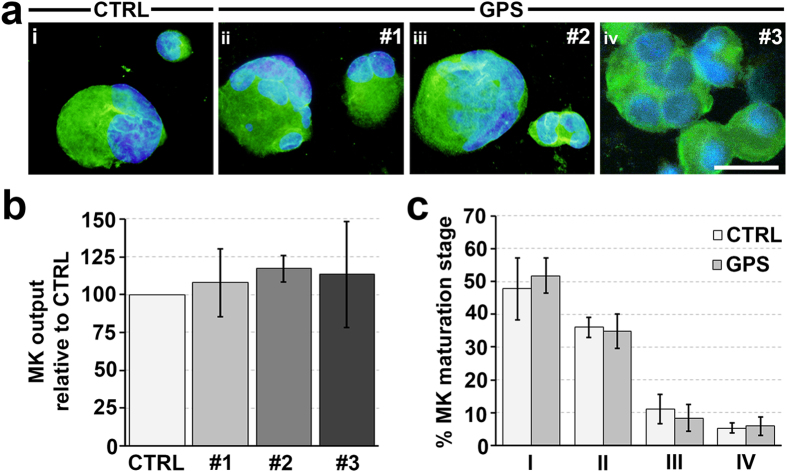
Normal differentiation of human megakaryocytes from patients with GPS.Hematopoietic progenitors from peripheral blood of healthy controls (CTRL) and patients with GPS were differentiated in culture into megakaryocytes in presence of TPO. (a) Representative immunofluorescence staining of plasma membrane CD61 in CTRL- (i) and GPS-derived megakaryocytes (ii–iv) (green = CD61; blue = nuclei; scale bar = 25 μm). (b) Statistical analysis of megakaryocyte (MK) output of GPS patients (#1, #2 and #3) relative to CTRL samples. Data are presented as mean ± SD (p = NS). (c) Statistical analysis of maturation stages in controls (CTRL)- and gray platelet syndrome patients- derived megakaryocytes (MK). Maturation stages were identified according to standard morphological criteria, as specified in the ‘Materials and Methods’ section. Data are presented as means ± SD of CTRL and all GPS patients GPS (p = NS). No differences were observed among patients.